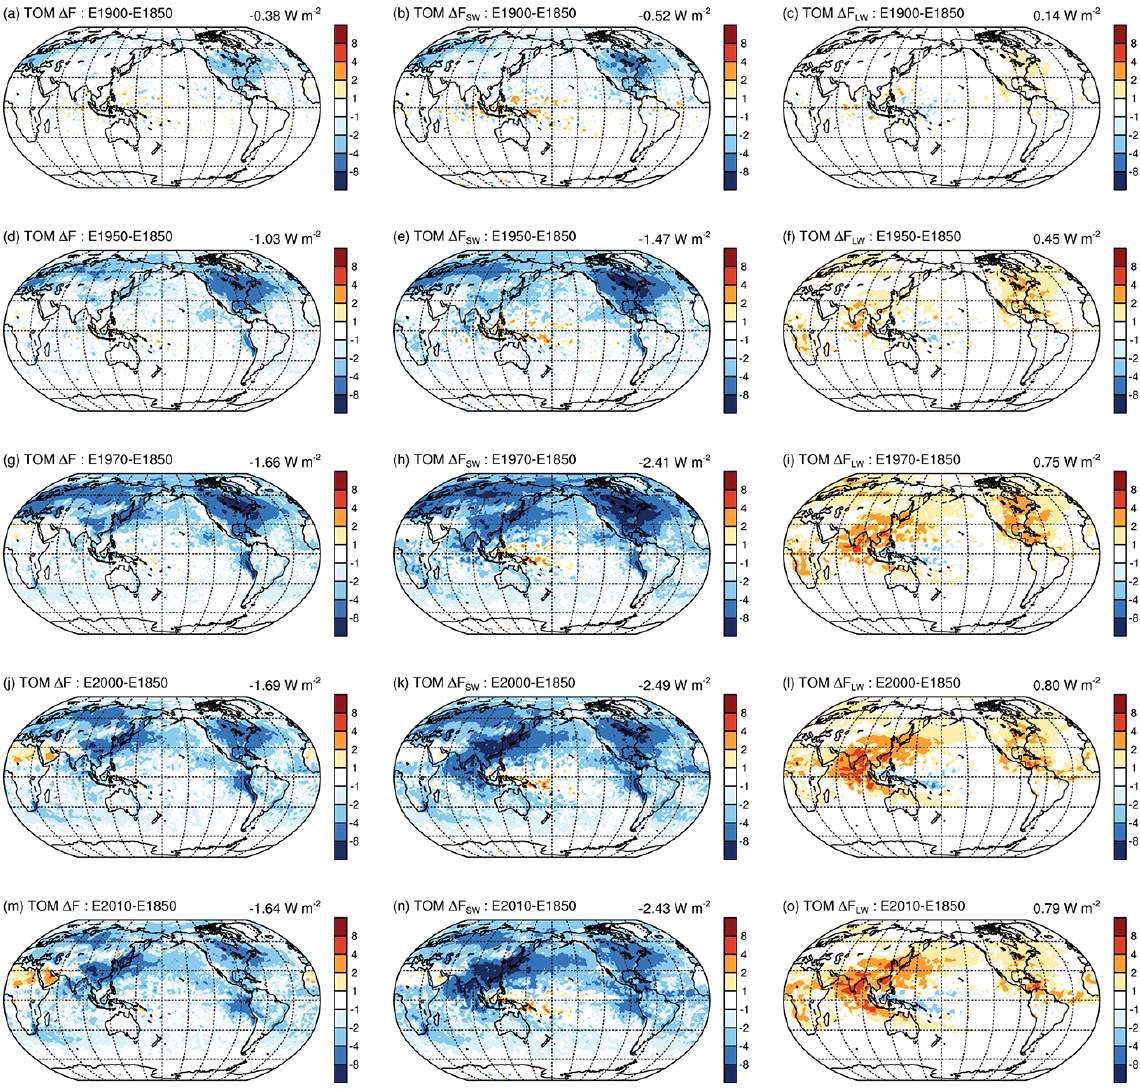
Figure 5. Geographical distributions of annual mean net (left), shortwave (middle), and longwave (right) ERF aer ( (cid:49) F, Wm − 2 ) at the top of the model (TOM) estimated for different time slices using nudged simulations. Numbers shown on the top right of each panel are global mean values. For a given time slice, the CMIP6 aerosol emissions for the corresponding year are used. Simulations are described in Table 1, and “E2010” represents the CTRL simulation. See Sect. 3.2 for